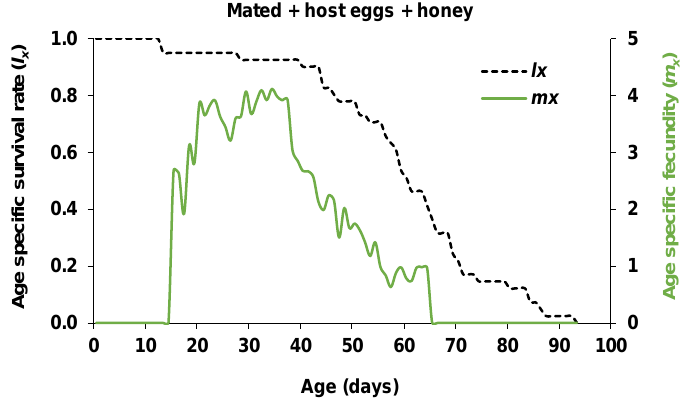
Figure 3. Age specific survival rate (dashed line) and fecundity (solid line) of mated Ooencyrtus lucidus on Bagrada hilaris eggs.